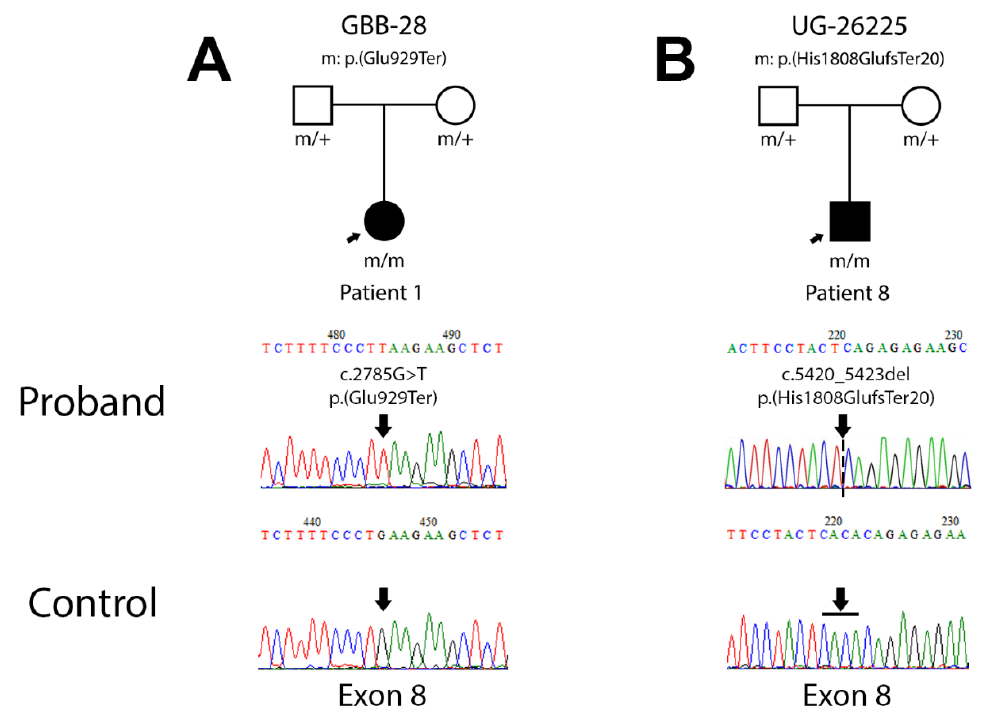
Figure 1. Pedigree chart and electropherogram for the patients carrying novel mutations. ( A ) Pedigree chart for family GBB- 28, carrier of mutation c.2785C>T; p.(Glu929Ter) and electropherogram of the proband sequence compared to the control. ( B ) Pedigree chart for family UG-26225, carrier of mutation c.5420_5423del; p.(His1808GlufsTer20) and electropherogram of the proband sequence compared to the